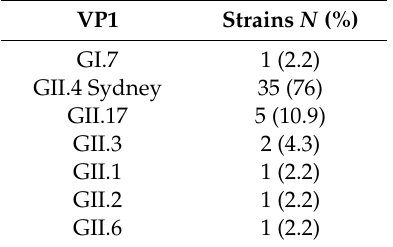
Table 2. Noroviruses VP1 gene genotyping.